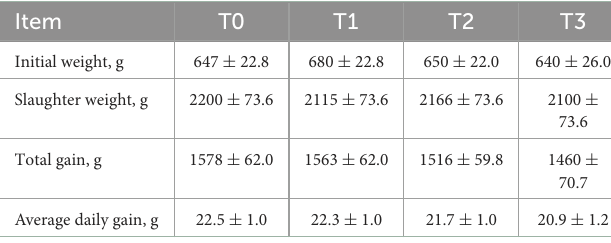
TABLE 3 The least-square means ± standard error of growth performance in the different groups studied.